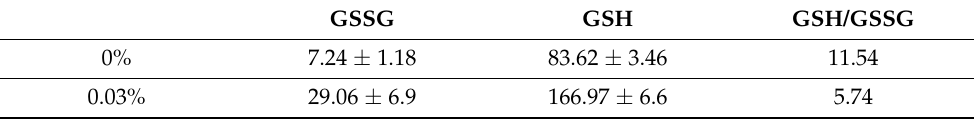
Table 3. The levels of reduced (GSH) and oxidized (GSSG) glutathione in small volume samples by modified RP-HPLC. The tested concentration of OptiBond Solo Plus in culture medium—0.03%. Experiments were run three times. The results from the representative experiment are shown. GSH = glutathione reduced, GSSG = glutathione oxidized. The data represent a mean with the SD value.